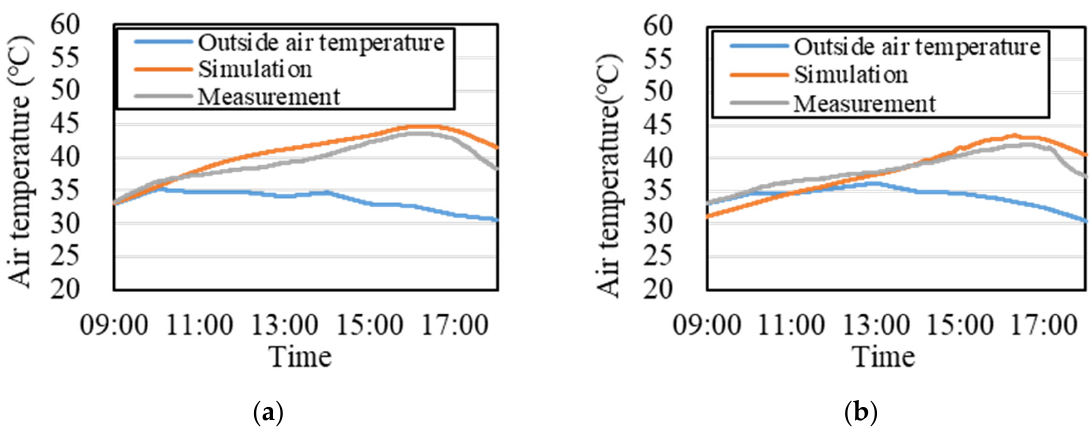
Figure 10. Air temperature comparison of simulation and measurement. ( a ) Without Expanded Metal Mesh; ( b ) With Expanded Metal Mesh.